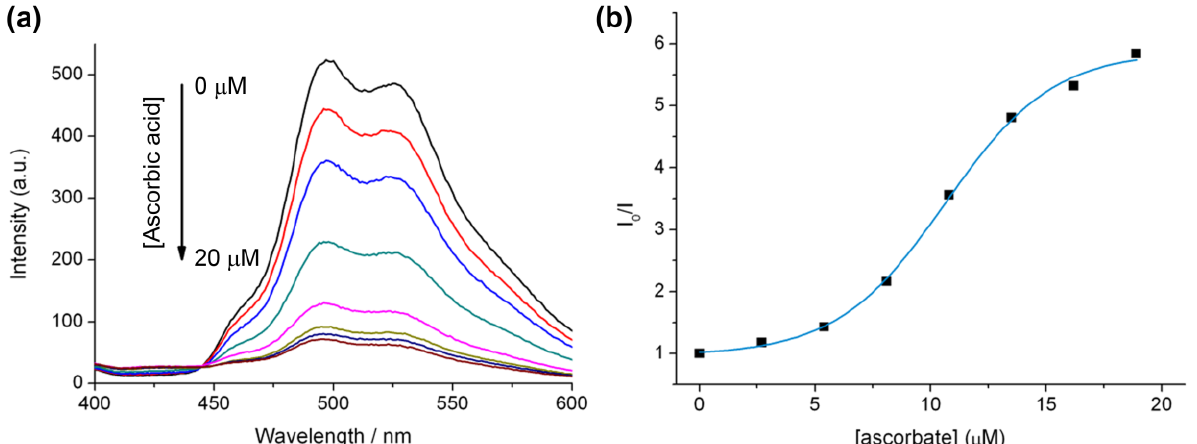
Figure 3. ( a ) Luminescent quenching of 7 upon the addition of ascorbate under aerated aqueous conditions at room temperature. Conditions, 7 (10 µM), HEPES buffer (20 mM) pH 7.0. ( b ) Decrease in λ (498 nm) for 7 (10 µM), HEPES buffer (20 mM) pH 7.0, as a max function of added ascorbic acid (from 0 to 20